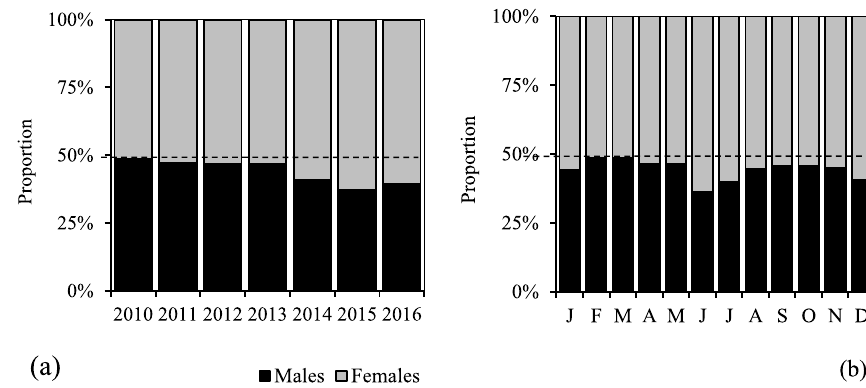
Fig. 3. Proportion of males and females of T. picturatus sampled off the Portuguese coast by year (a) and by month (b).